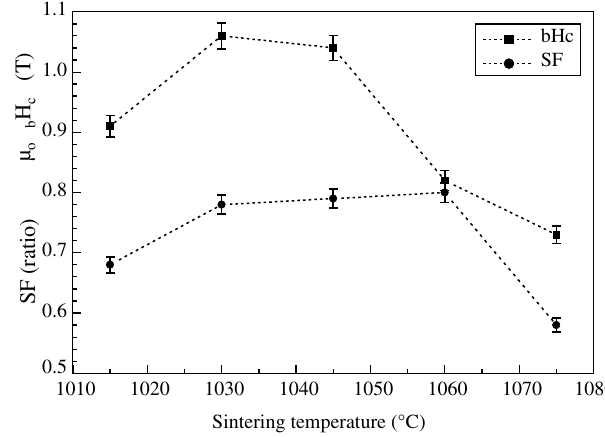
Figure 6. Remanence and energy product vs. sintering temperature for Fe B HD magnets prepared using a hydride powder milled for Pr 16 76 8 20 hours.